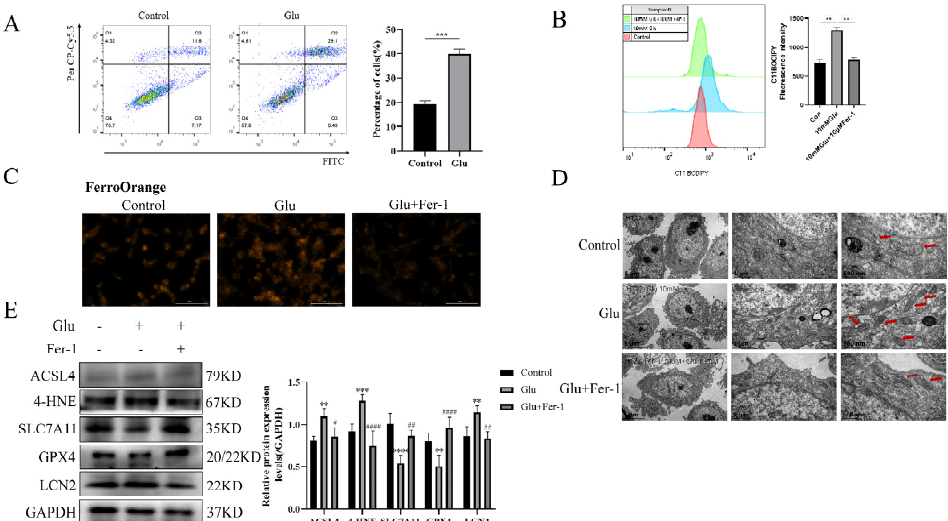
Figure 5. Glutamate stimulation of HT22 cells induces high expression of LCN2 in ferroptosis. Glutamate stimulation of HT22 cells with or without pre-treatment with Fer-1. ( A ) Representative results of annexin V-FITC/PI staining and quantitative analysis after the treatment (glutamate 10 mM) for 24 h. The mean ± SD is shown. Unpaired two-tailed t test was used for statistical analysis. *** p < 0.001. ( B ) Detection of C11-BODIPY 581/591 fluorescence of HT22 cells by flow cytometry. Glutamate: 10 mM, Fer-1: 10 µ M, treatment time: 24 h. **: It represents the glutamate stimulation group compared with the control group or glutamate combined with Fer-1 group, p < 0.01. ( C ) Detection of Ferro Orange fluorescence of HT22 by multifunctional microplate detection system. Glutamate: 10 mM, Fer-1: 5 μ M, treatment time: 24 h. Scale bar is 100 μ m. ( D ) Representative TEM images of the untreated group, the glutamate-treated group and the glutamate-co-administered Fer-1 group. The red arrows represent mitochondria. Glutamate: 10 mM, Fer-1: 10 μ M, treatment time: 24 h. Scale bar = 500 nm, 1 μ m, 5 μ m. ( E ) Western blotting analysis and quantitative analysis of ACSL4, 4HNE, SLC7A11, LCN2, GPX4 and GAPDH expression in HT22. Glutamate: 10 mM, Fer-1: 5 μ M, treatment time: 24 h. **/***/****: It indicates that the glutamate-treated group compared to the blank control group, ** p < 0.01, *** p < 0.001, **** p < 0.0001. #/##/####: It indicates that pretreatment of the glutamate group with Fer-1 compared to that without Fer-1, # p < 0.05, ## p < 0.01, #### p < 0.0001. Two-way ANOVA multiple comparisons were performed between groups.